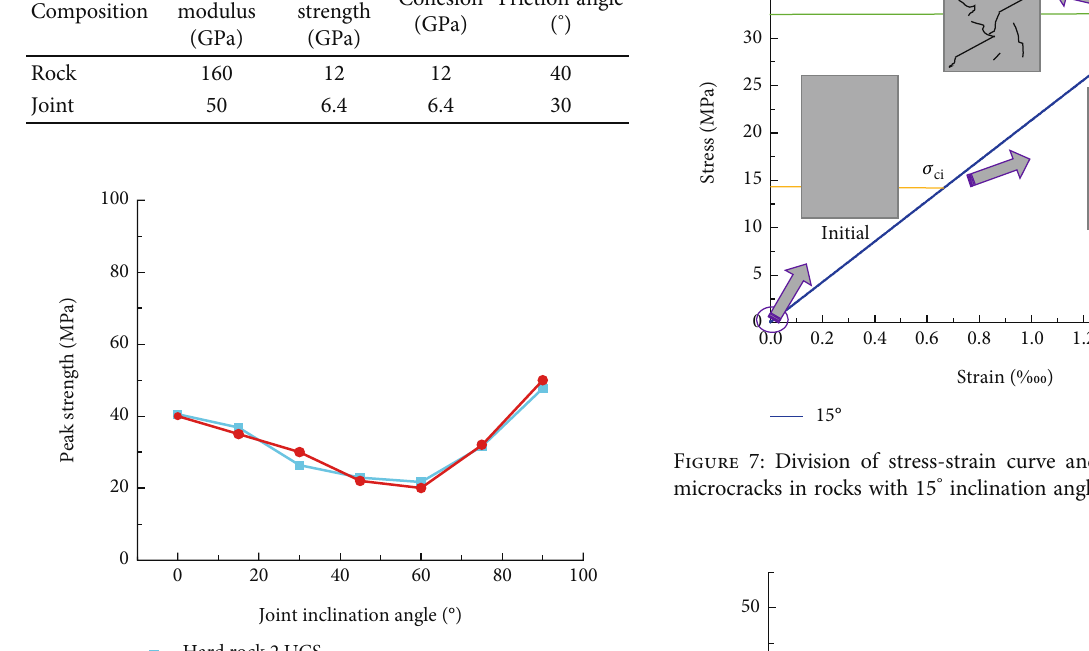
Table 1: Numerical simulation parameters for jointed rock masses.